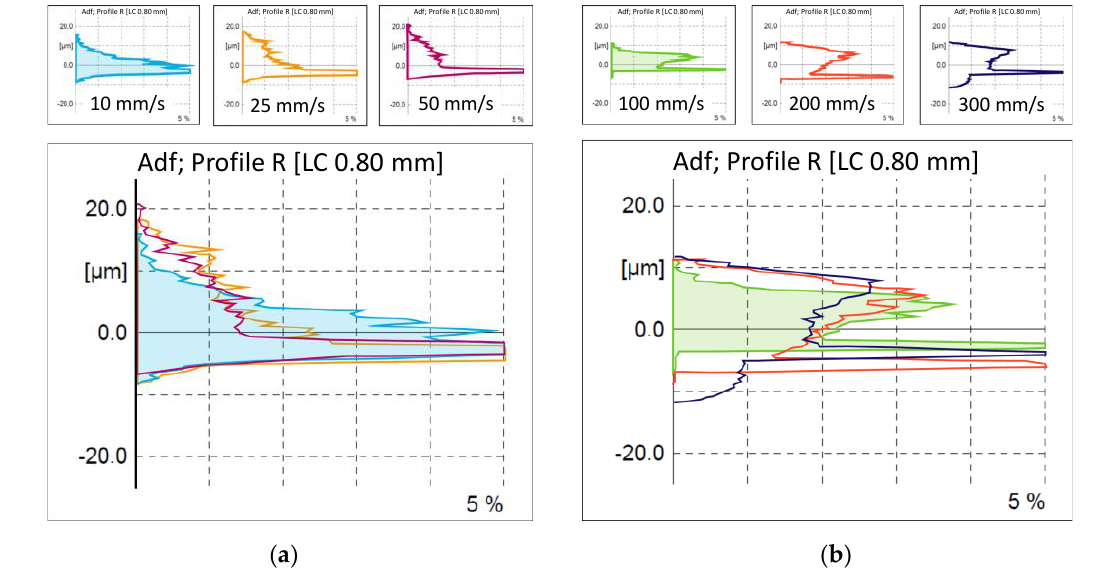
Figure 2. Di ff erent behaviors of the probability density function as a function of V s . (Lc cut-o ff wavelength). ( a ) Single maximum Adf value, ( b ) Double maximum Adf